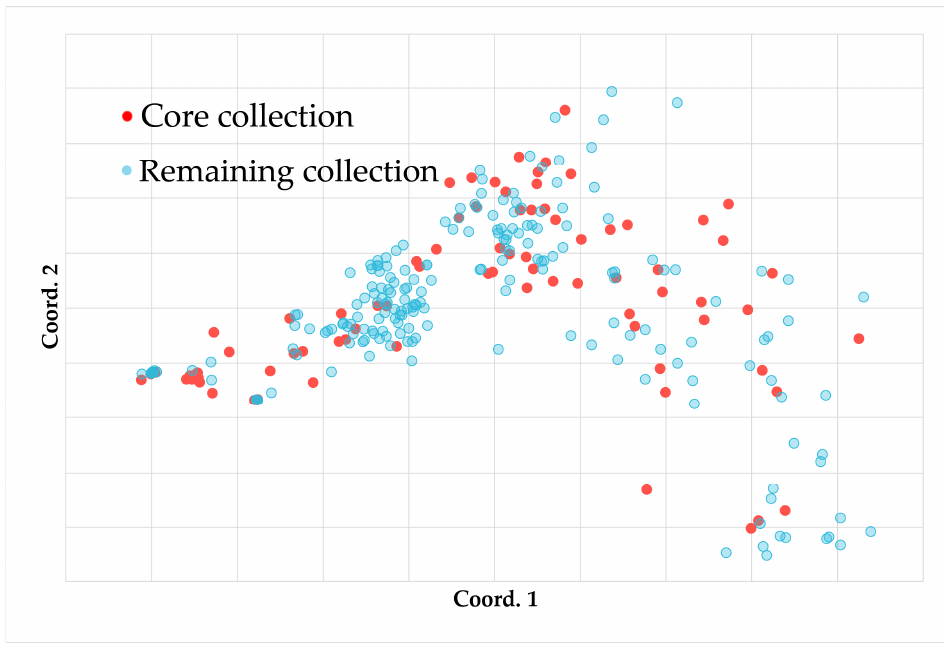
Figure 4. Distribution of principal coordinates of the core collection in all